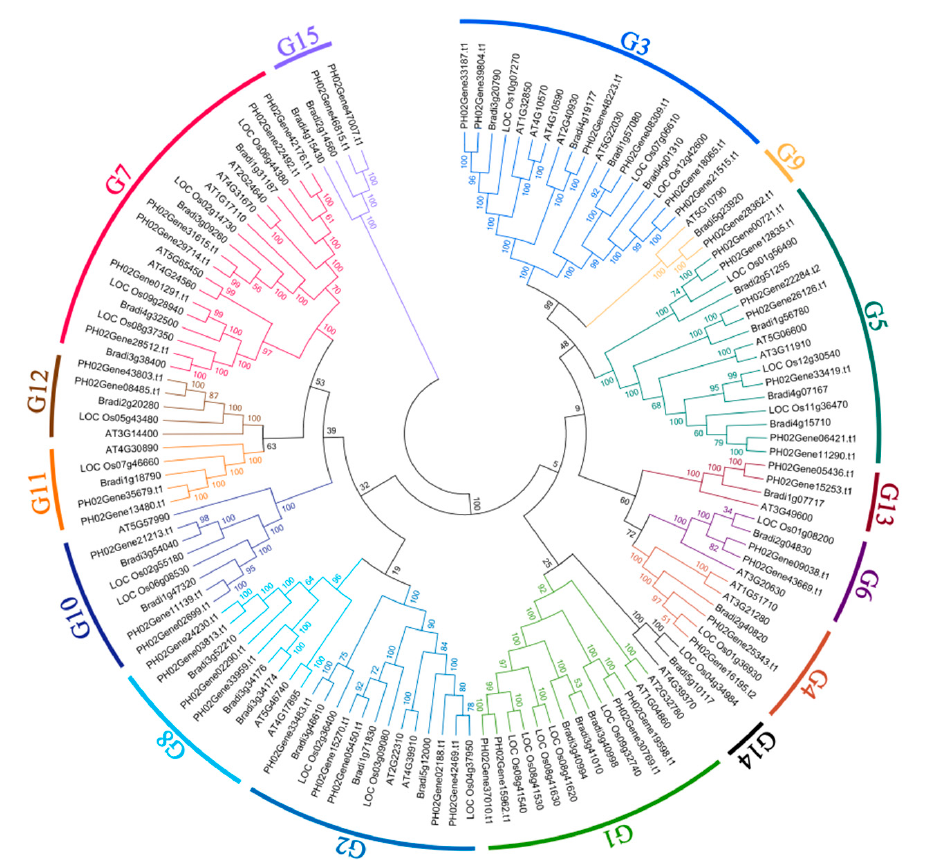
Figure 2. Phylogeny of PeUBP proteins from moso bamboo, Arabidopsis thaliana , rice, and Brachypodium distachyon . The tree was generated using the Neighbour-joining method with 1000 replicates. The branches of each group are indicated in a specific color.